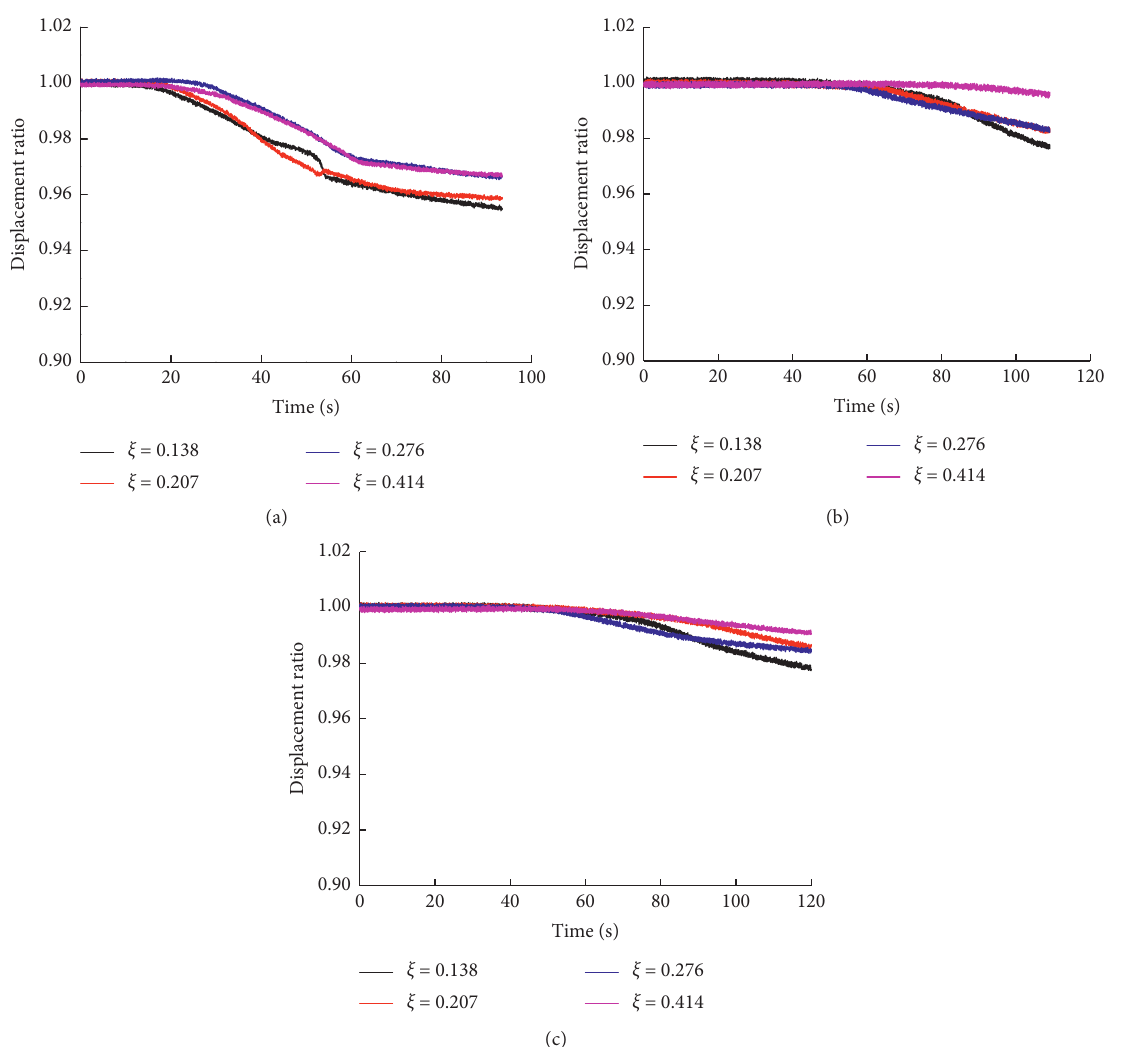
Figure 7: The time history curve of the axial displacement variation coefficient of rubber fiber concrete. (a) C-0%-0%. (b) C-30%-0%. (c) C-